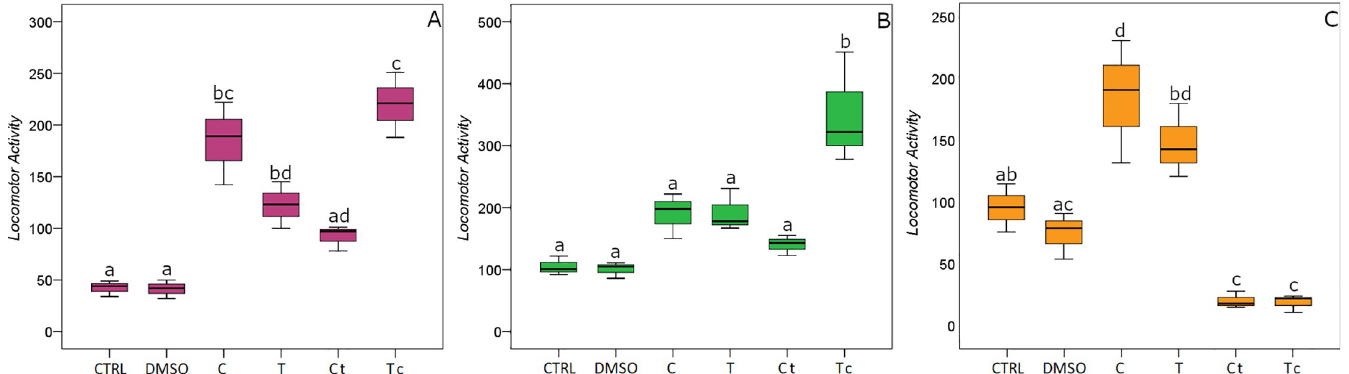
Fig 1. Ant locomotor activity. Data are expressed as the frequency of crossing the bisector traced on the Petri lid, taken as a proxy for worker locomotor activity affected by treatments (C: carvacrol; T: thymol; Ct: 3:1 (v/v) carvacrol/thymol; Tc: 1:3 (v/v) carvacrol/thymol) and controls (CTRL and DMSO) on Formica cinerea (A), Tetramorium caespitum (B) and Myrmica scabrinodis (C). Boxplots show median, quartile, maximum and minimum values; different letters indicate significant differences (Tukey’s HSD post hoc, P < 0.05; S2 Table).